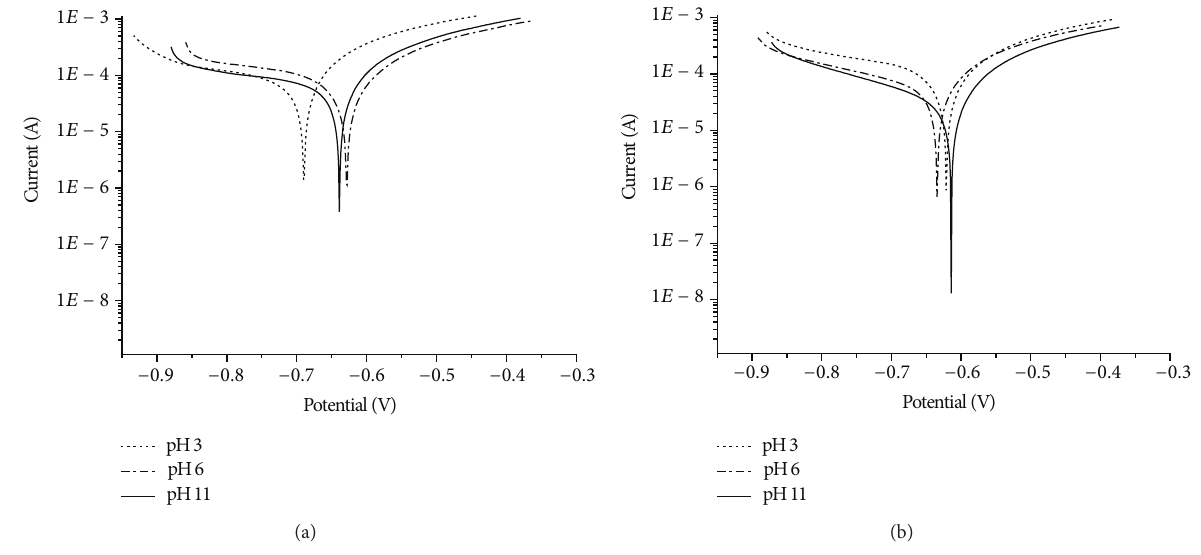
Figure 6: Polarization curves obtained on carbon steel after 30 minutes of exposure to Na 2 SO 4 10mM solution at three different pH values (3, 6, and 11) without the addition of nanoparticles (a) and with the addition of 2 mg/mL of loaded/encapsulated mesoporous silica nanoparticles (b).